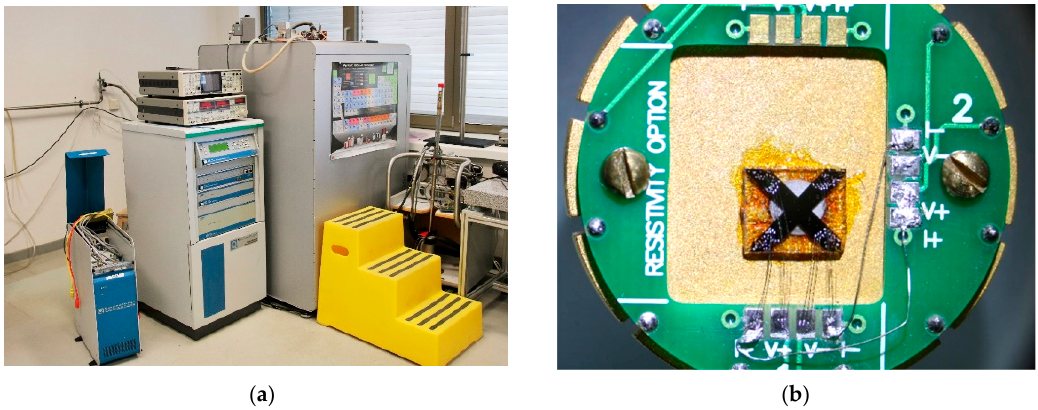
Figure 3. Experimental setup for high magnetic field testing of metal Hall sensors: ( a ) Super-conducting Physical Property Measurement System PPMS14; ( b ) Sensor sapphire substrate with the chromium layer installed on the PPMS puck.